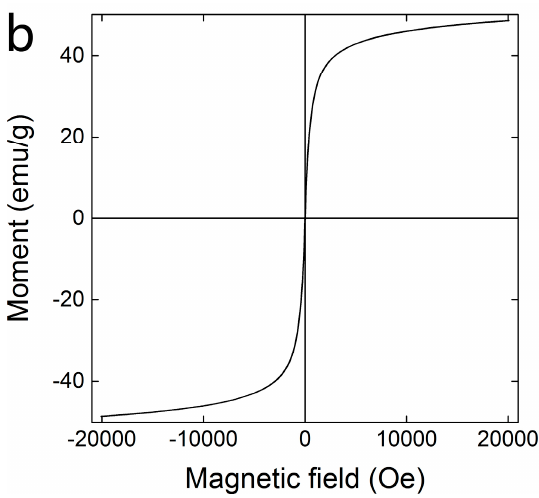
Figure 2. Nitrogen adsorption isotherm ( a ) and magnetic hysteresis loop ( b ) of FTCNCs.